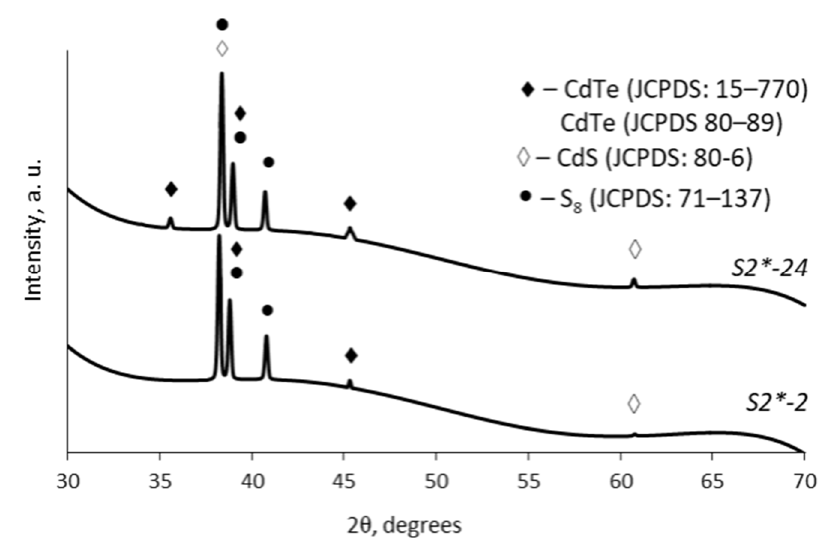
Figure 6. X-ray diffraction patterns of the layers of cadmium chalcogenides on PA 6 films surface. Table 6. XRD peak assignments of cadmium chalcogenide layers on PA 6.